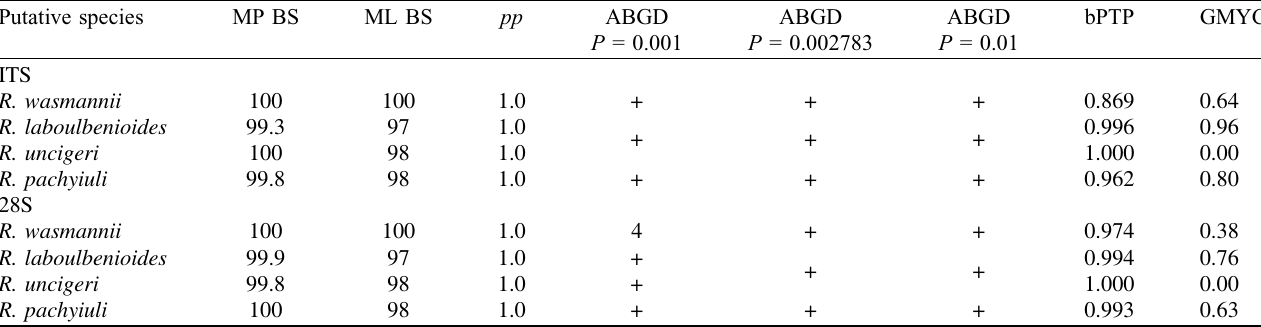
Table 2. Summary of results of MP, ML, BI, and species delimitation analyses (ABGD, bPTP, GMYC). Explanation of symbols and values used: pp = posterior probability; + under ABGD represents supported clades; 4 under ABGD means that the analysis found support for 4 species hypotheses ( fi de [55]) within R. wasmannii under prior maximum distance ( P ) = 0.001, 0.001292, and 0.001668; numbers under bPTP and GMYC are Bayesian support values for delimited species